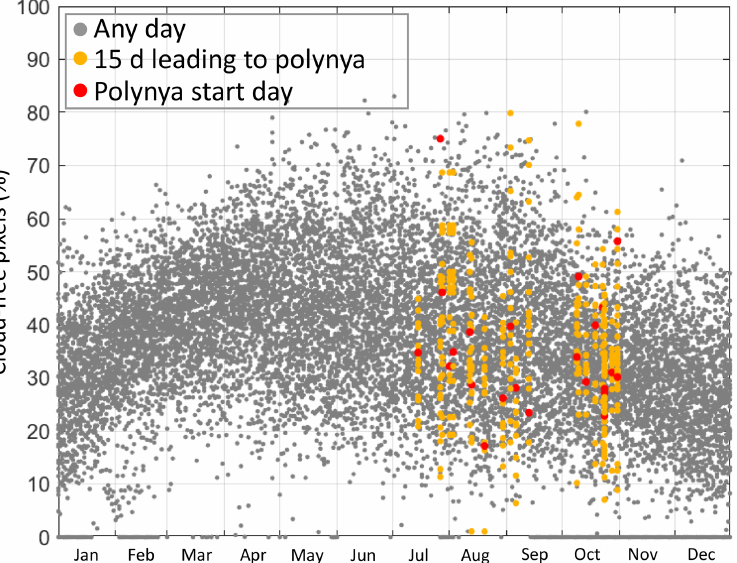
Figure B1. For each day of the year, percentage of cloud-free pixels (out of 90000) for any year sampled by APP (grey), for the 15d leading to a polynya event (orange), and the days a polynya opens